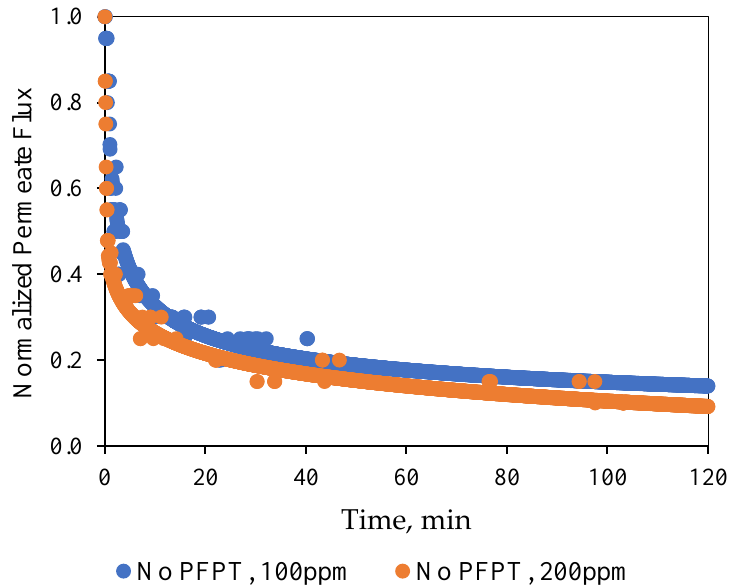
Figure 5. Normalized permeate flux behavior as a function of time for normal filtration mode at TMP: 1.5 bar and CFV: 1 m/s.